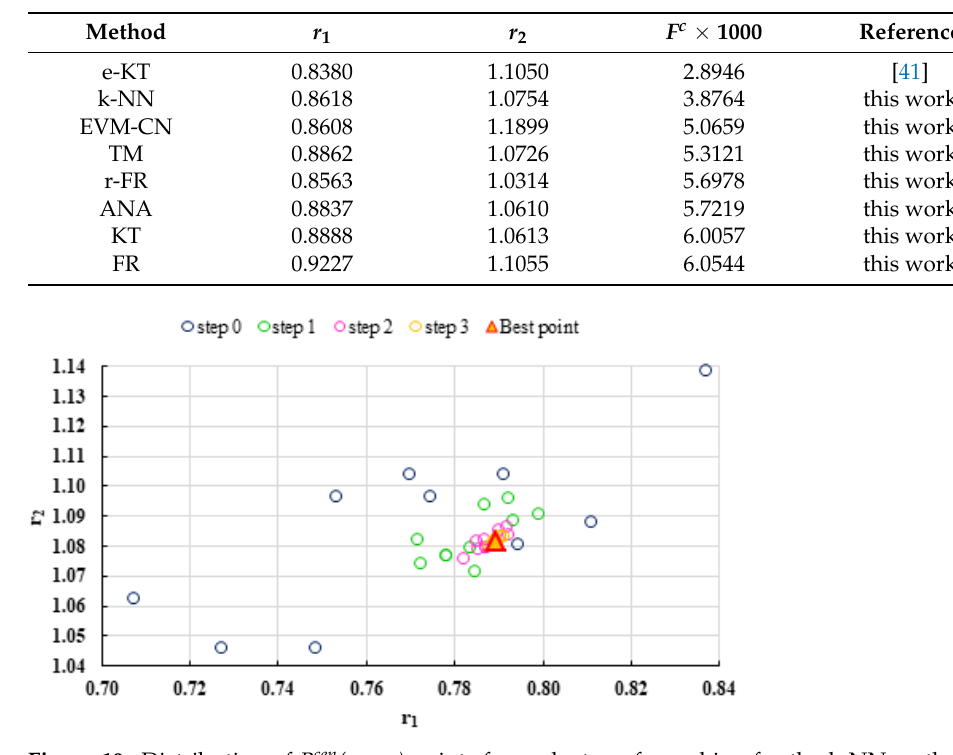
Figure 19. Distribution of P cen (r 1 , r 2 ) points for each step of searching for the k-NN method for copolymerization of 2-( N -phthalimido) ethyl acrylate with 1-vinyl-2-pyrolidone (NPEA-NVP) [39].